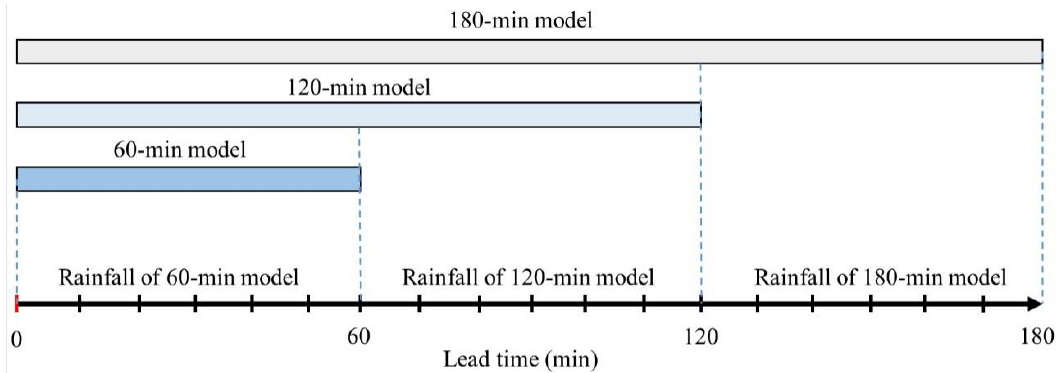
Figure 5. The approach of the data-driven models for combining the corrected rainfall from the 60 min, 120 min, and 180 min models.